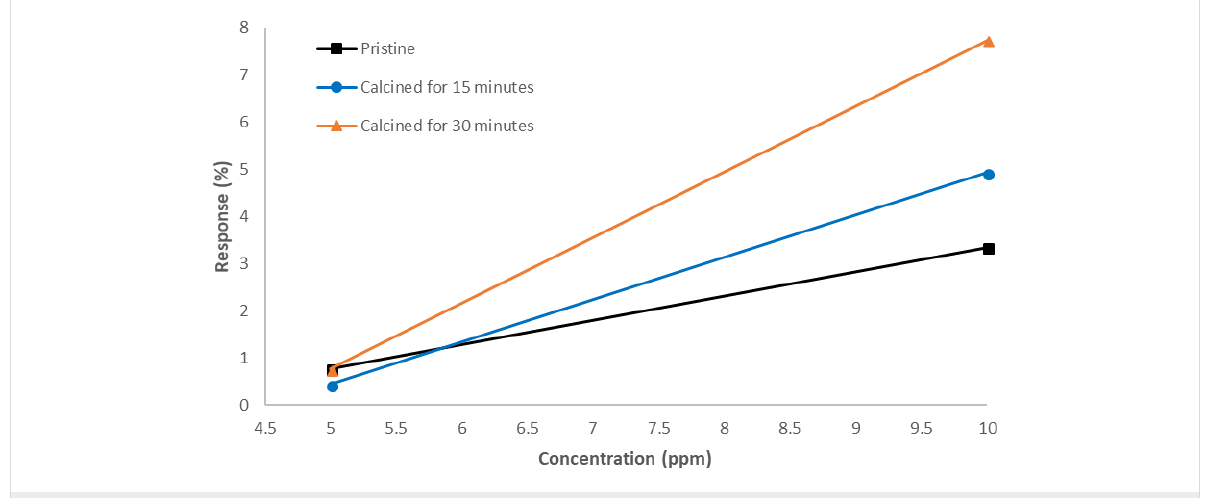
Figure 10: Effect of calcination period on the gas sensing performance.